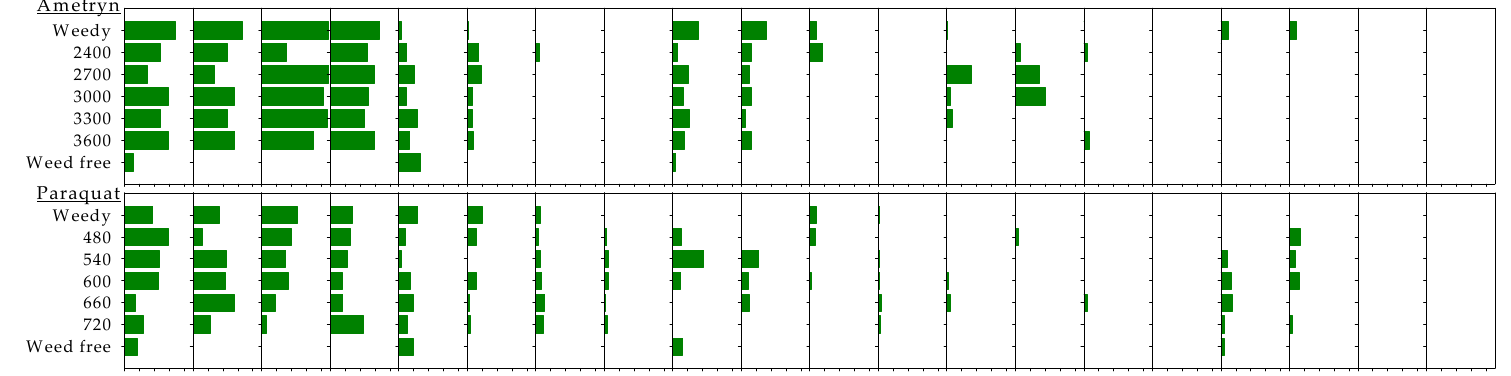
Figure 6. Effects of ametryn and paraquat applications on number of weeds and biomass of the top-five weed species in Experiment II at before application (BA) 30 day after application (DAA), 90 DAA, and 120 DAA. The data measured from 2 m 2 , not statistically analyzed. The green bars represent number and biomass of individual weed species.